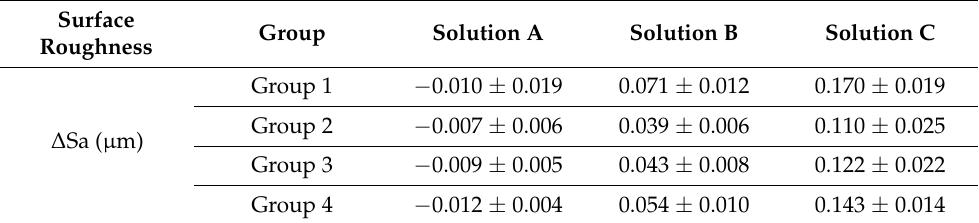
Table 4. Mean surface roughness change ( ∆ Sa) among the four